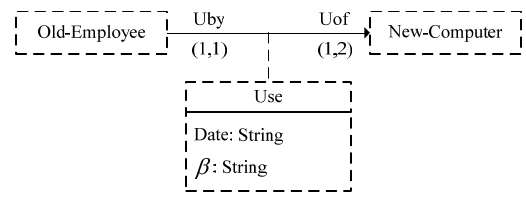
Fig. 5. Representation of a fuzzy association ( class ) in a fuzzy UML